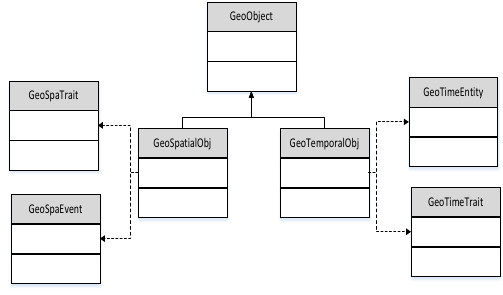
Figure 3. Spatiotemporal object concept